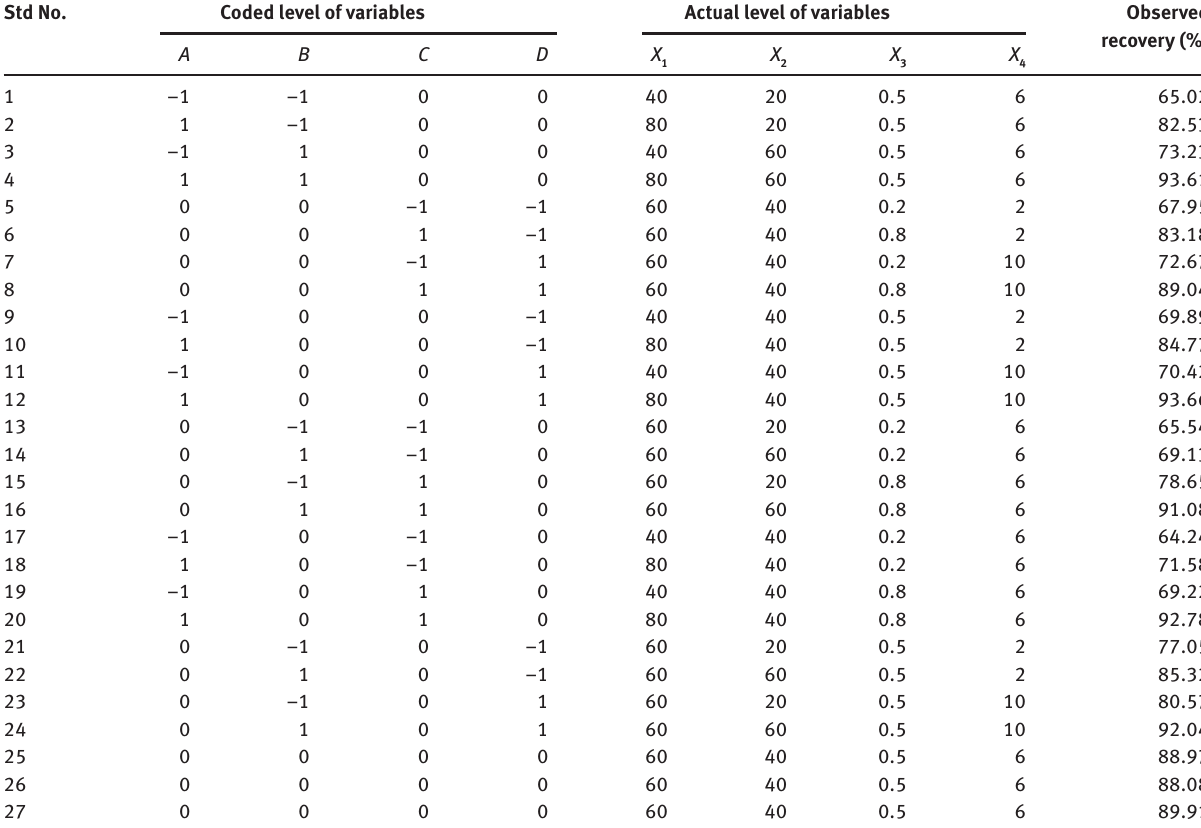
Table 3: Box-Behnken experimental design and response value. Std No. Coded level of variables Actual level of variables